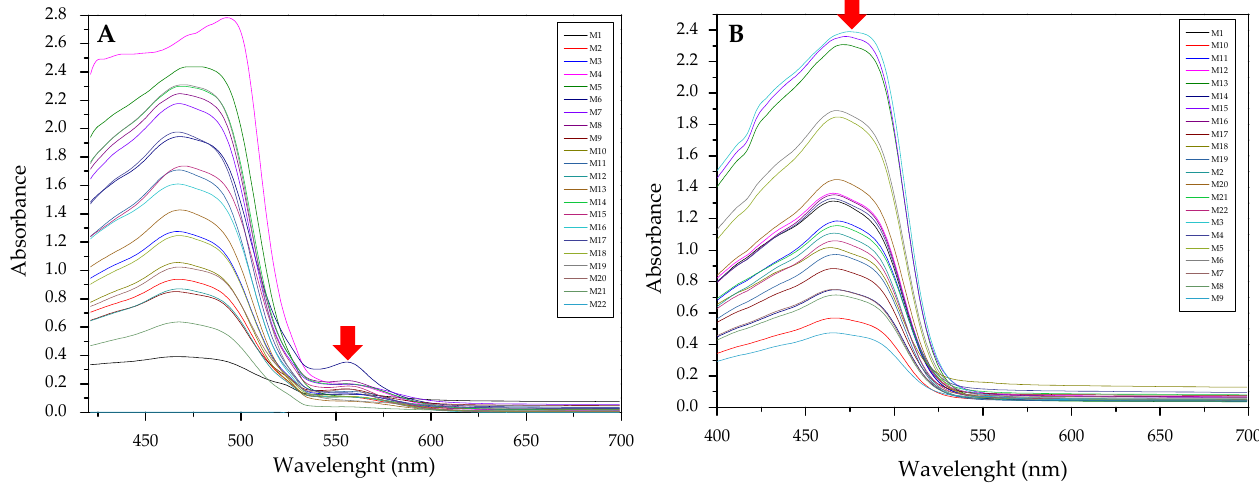
Figure 5. Visible spectra of the membranes before ( A ) and after complexation ( B ) for the system PAN–Pb(II).